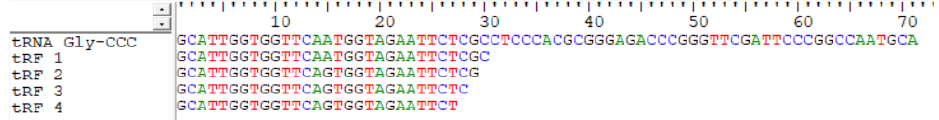
Figure 3. An example of identified tRFs derived from tRNA Gly ‐ CCC. All tRFs were classified as 4 different tRFs.